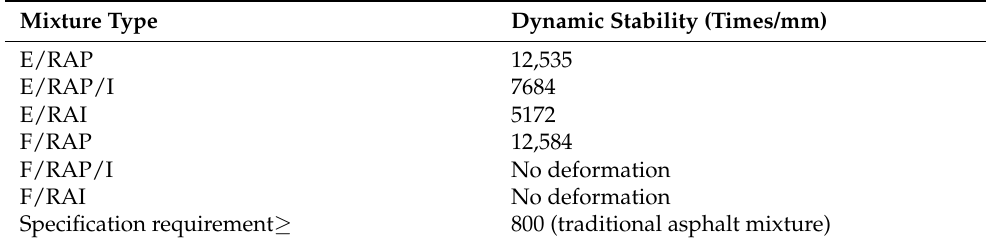
Table 4. Dynamic stability of different CRMs.